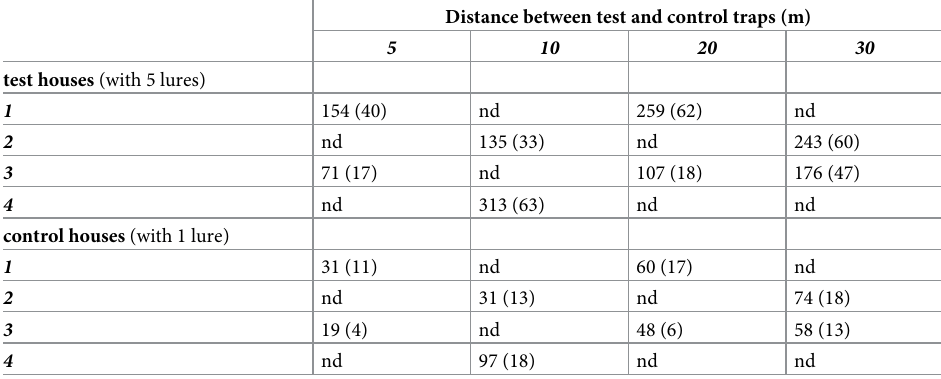
with mean parameter μ modelled as